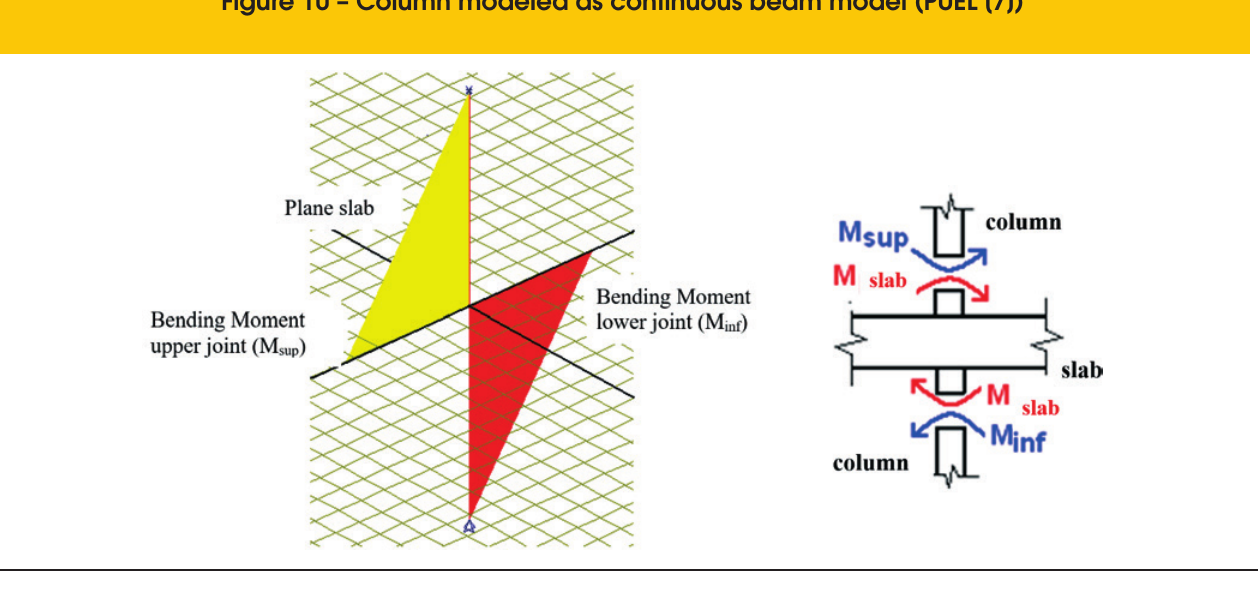
Figure 10 – Column modeled as continuous beam model (PUEL [7])